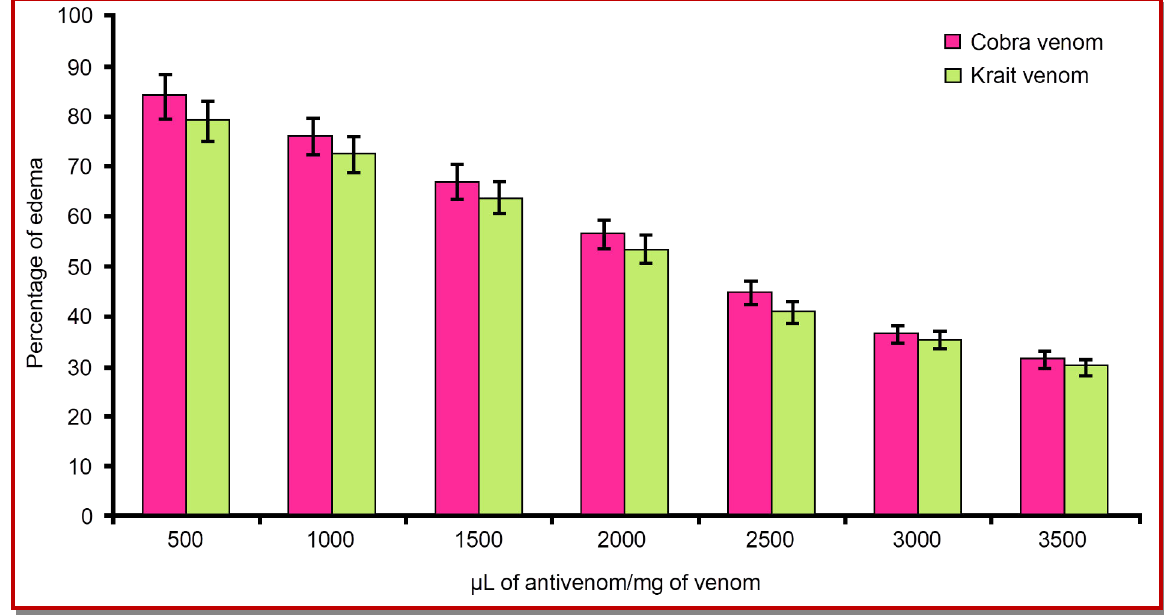
Figure 1: Neutralization of edema induced by Cobra and Krait venom by Mimosa pudica plant extracts in experiments with pre- incubation. Various mixtures of Cobra and Krait venom and Mimosa pudica plant extracts were incubated and tested in the foot- pad assay. Edema was assessed 1 hour after injection and expressed as percentage. Edema induced in control mice (venom alone) was considered as 100% activity. Mimosa pudica plant extracts inhibited the edema forming activity and edema was reduced up to 30%. P<0.005 at all antivenoms/venom